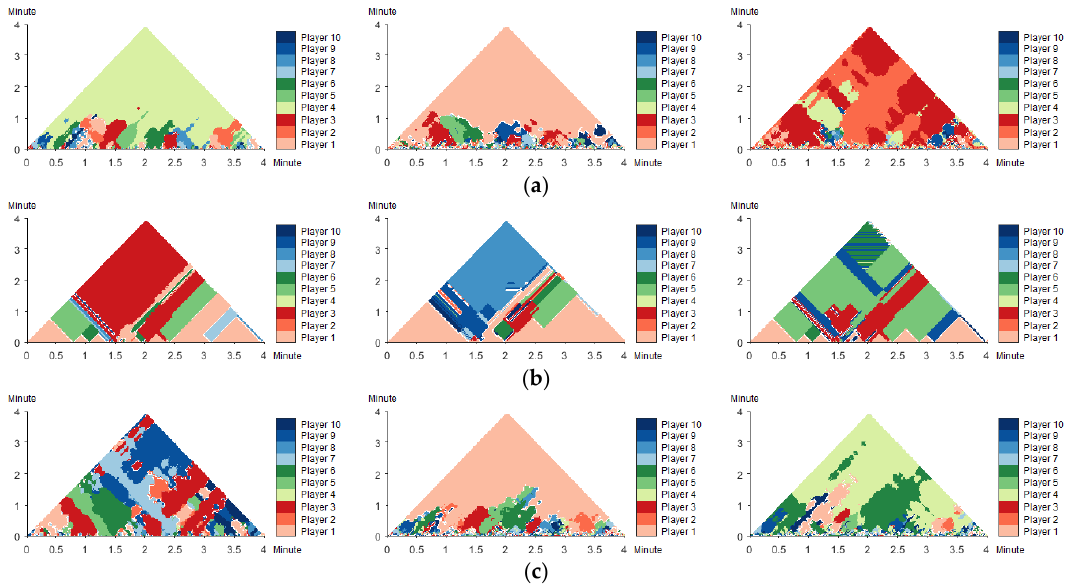
Figure 11. The most central players in each interaction pattern during all time intervals based on the centrality measures (from left to right: degree, betweenness and closeness): ( a ) the attraction pattern; ( b ) the stability pattern, and ( c ) the avoidance pattern.